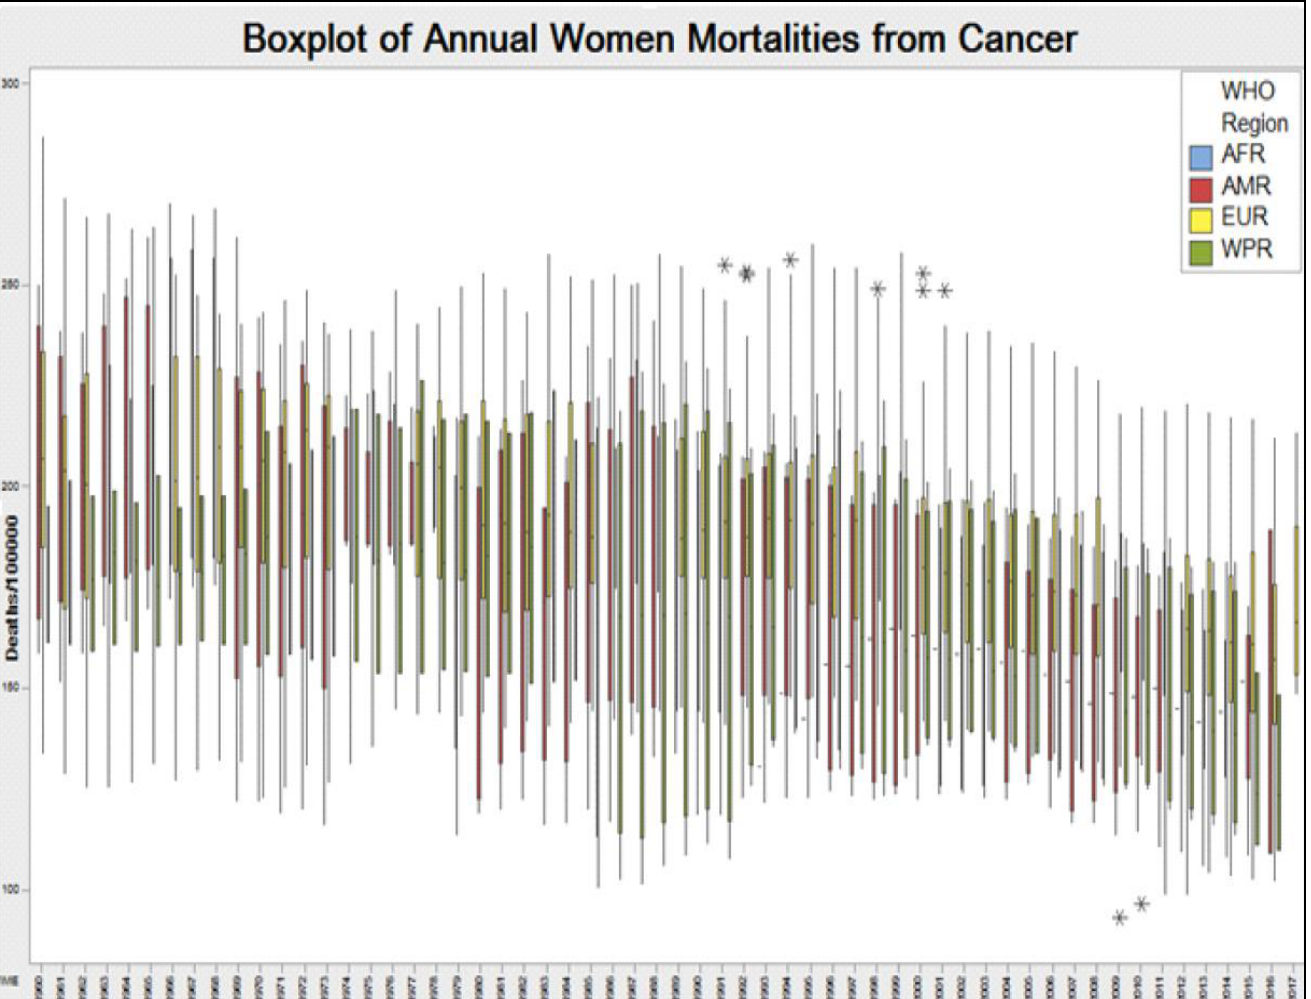
Figure 3 : Dataset segregation based on WHO geographical distribution by time order shown as Box plot, indicating data spreading and the aberrant mortality rates records generated using Minitab